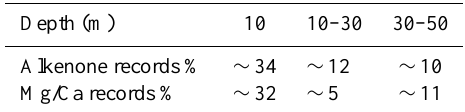
Table 4. Best fit for alkenone and Mg/Ca records for different layers of the